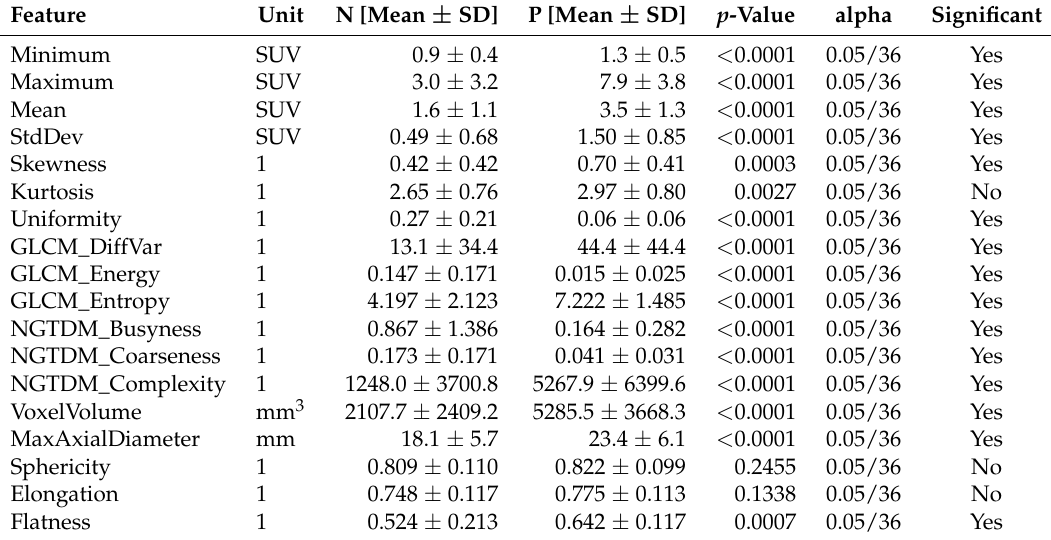
Table 4. Pairwise comparison between average feature values of PET radiomics features in the malignant (“P”) and benign (“N”) group. Symbol “1” in the “Unit” column indicates a dimensionless